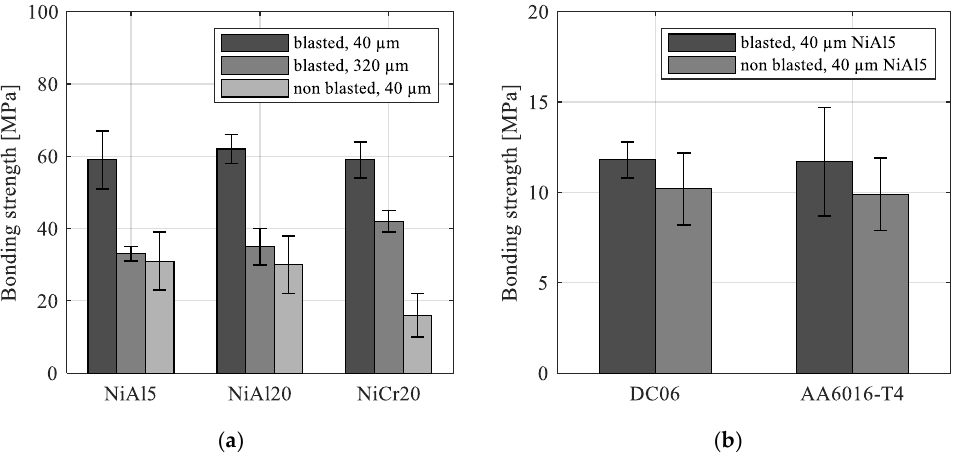
Figure 5. Bonding strength under axial tension ( a ) thermal spray layer to DC06 substrate; ( b ) FRP to thermal spray layer (NiAl5).